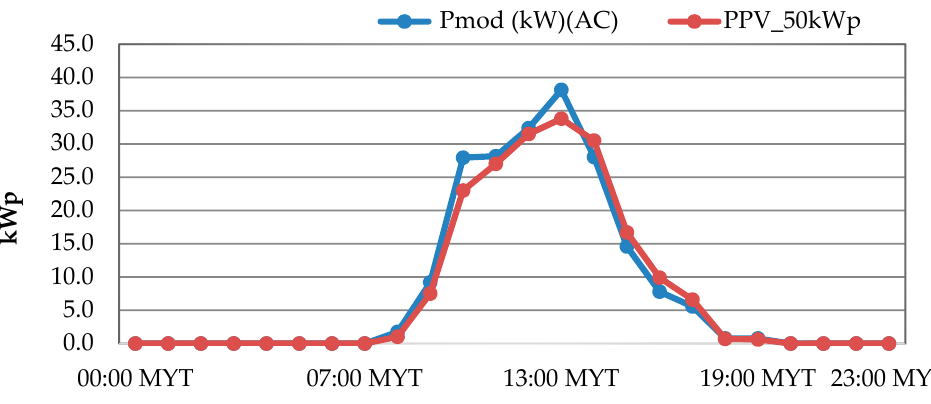
Figure 6. Modelled PV power (Indirect method). Table 9. PV model validation data with 50 kWp PV Figure 6 . Modelled PV power (Indirect method).